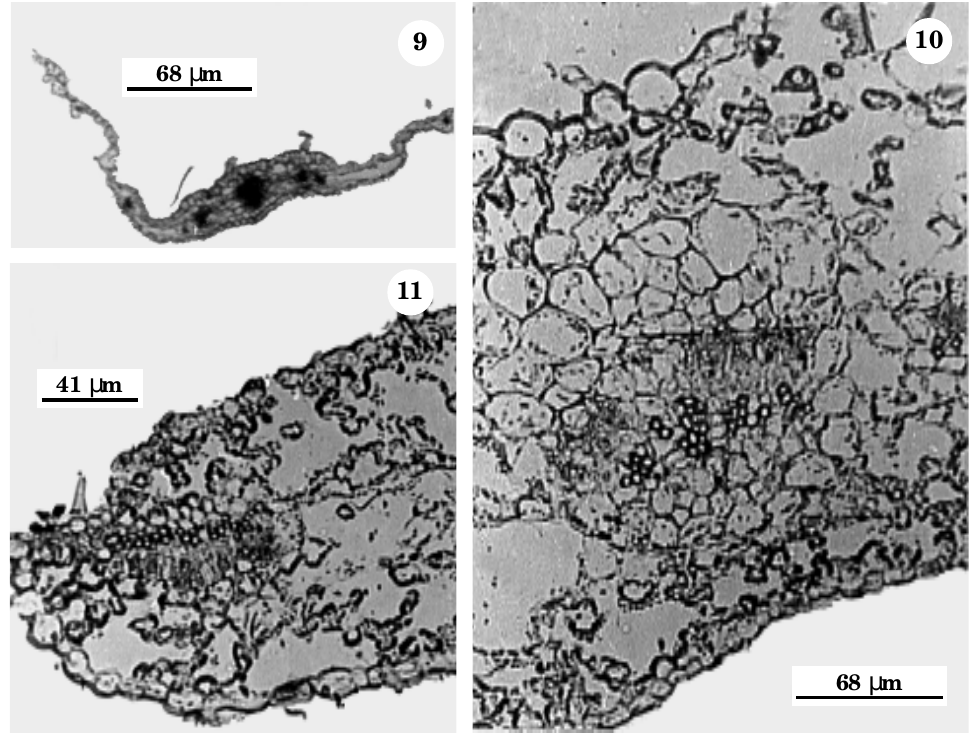
Fig. 9-11. Cross sections of petal of Marmande tomato flower infected with TMV-M showing the general form of infected petal (9), magnified part of midvein (10), magnified part of lateral vein (11).